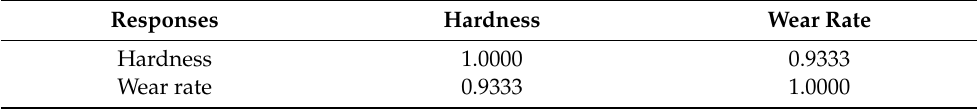
Table 6. Correlation coefficient of responses.